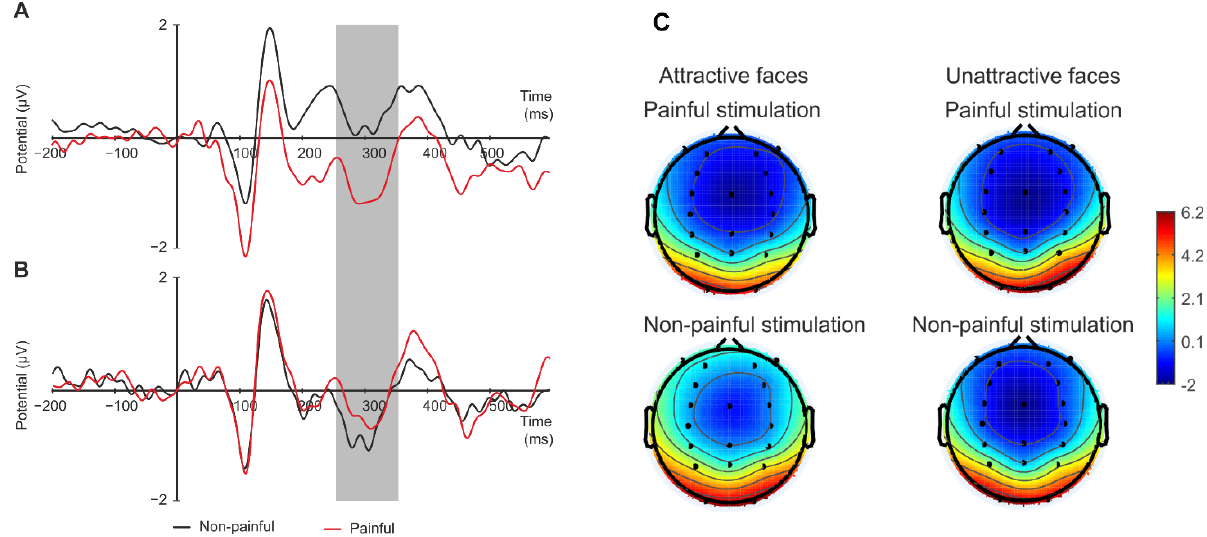
Figure 2. ( A – C ) N2 (250 ‐ 350 ms), recorded at a selection of average frontal electrodes, relative to the two stimulation conditions (painful vs non ‐ painful) for attractive faces ( A ) and unattractive faces ( B ). ( C ) Topographic maps of the N2 ERP component.